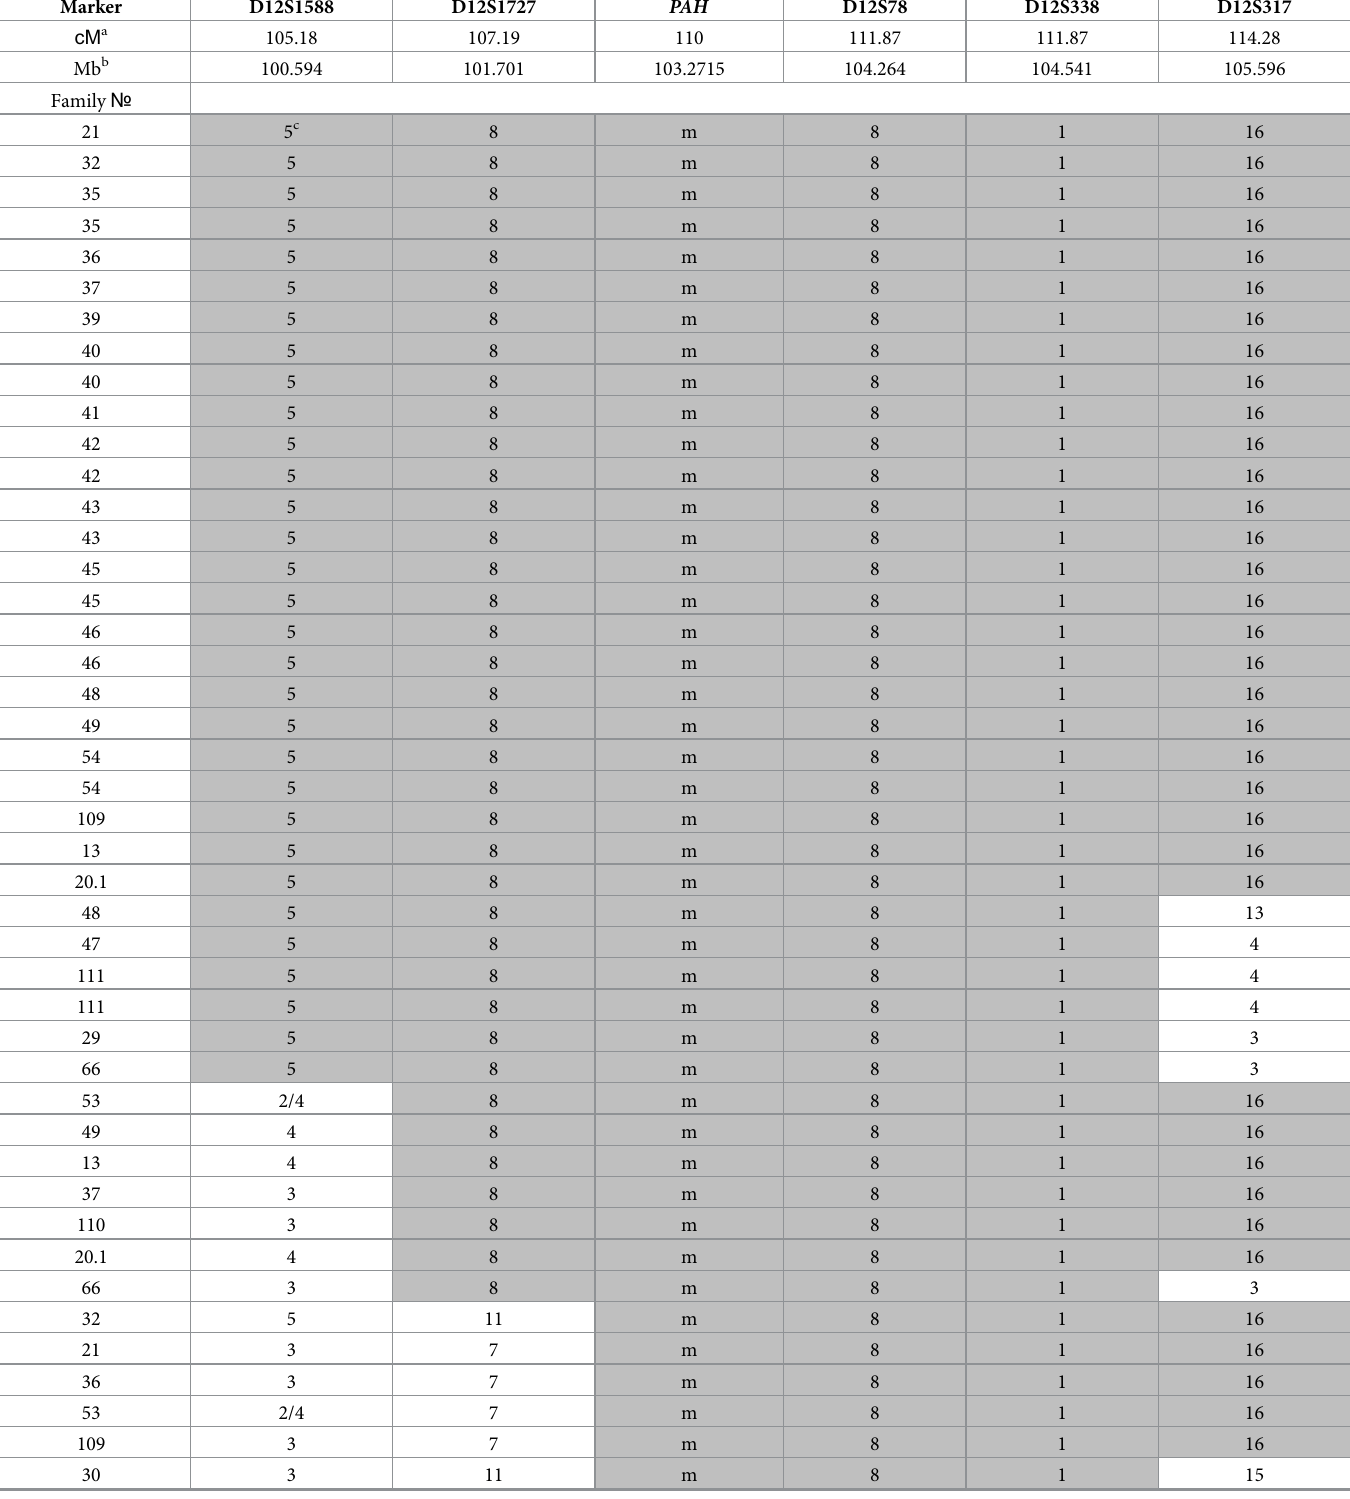
Table 3. Haplotypes of p.Arg261 (cid:3) -bearing chromosomes at five microsatellite